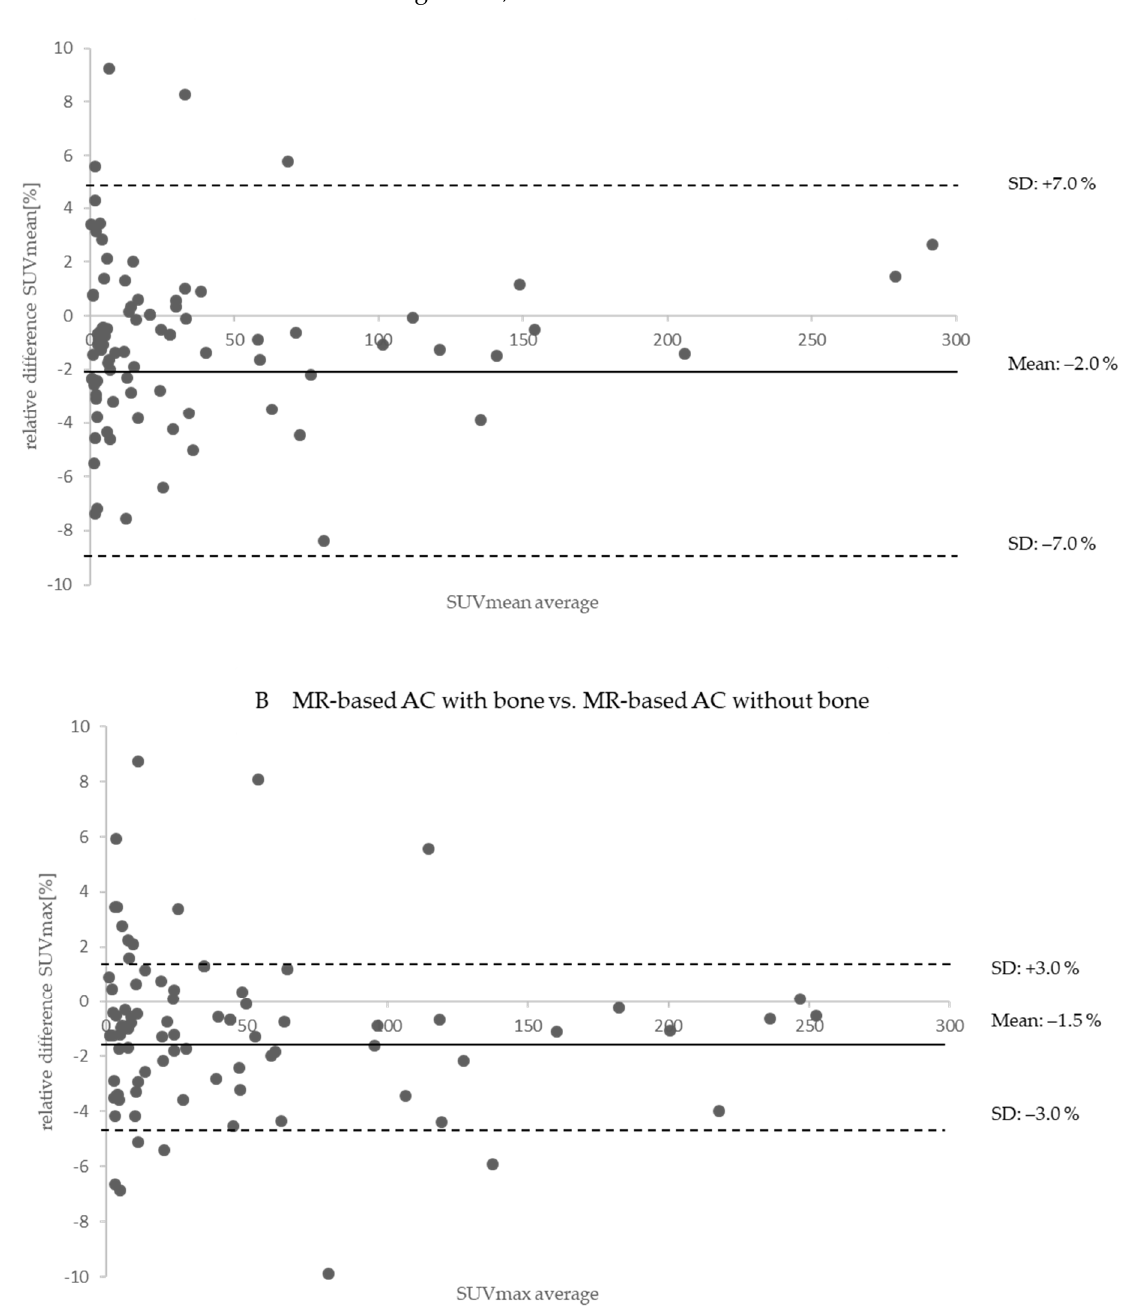
Figure 6. ( A ) Bland–Altman plot shows the relative quantitative impact on PET data in PET/MR between MR ‐ based attenuation correction map (AC map) with bone atlas (reference) and MR ‐ based AC map without bone atlas on standardized uptake values of SUV mean in 111 detected iodine ‐ positive lesions. MR ‐ based AC with missing bone information tended to slightly underestimate the PET signal compared to MR ‐ based AC with bone atlas (reference). ( B ) Bland–Altman plot shows the relative quantitative impact on PET data in PET/MR between MR ‐ based attenuation correction map (AC map) with bone atlas (reference) and MR ‐ based AC map without bone atlas on standardized uptake values of SUV max in 111 detected iodine ‐ positive lesions. MR ‐ based AC with missing bone information tended to slightly underestimate the PET signal compared to MR ‐ based AC with bone atlas (reference).